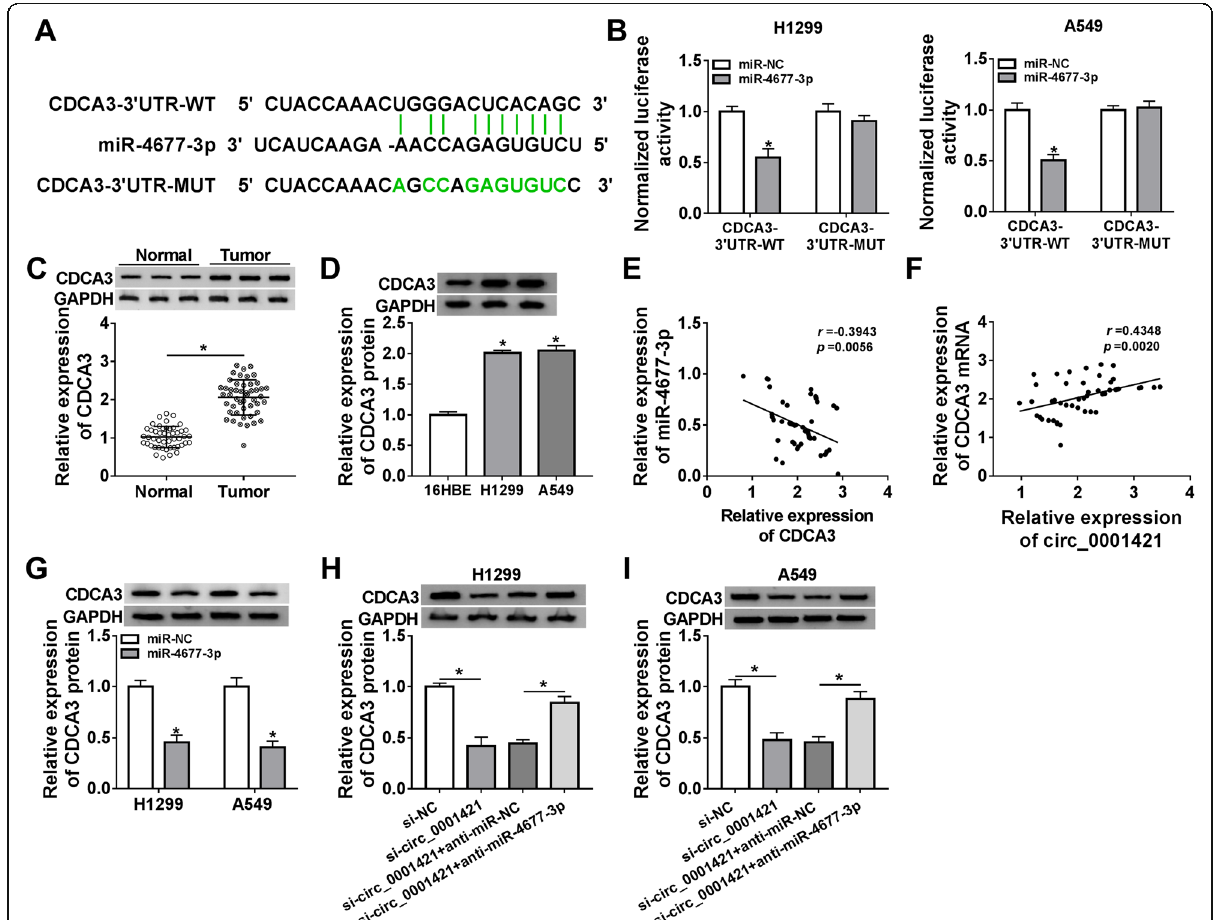
Fig. 5 CDCA3 was a target gene of miR-4677-3p in LC. a The predicted binding sites between miR-4677-3p and CDCA3 were shown. b The relationship between miR-4677-3p and CDCA3 in H1299 and A549 cells was analyzed by dual-luciferase reporter assay. c-d The protein of CDCA3 in LC tissues and cells versus that in normal tissues and cells was examined by western blot. e The correlation between miR-4677-3p and CDCA3 expression was appraised in LC tissues through Pearson coefficient analysis. f The correlation between miR-4677-3p and circ_0001421 level was appraised in LC tissues through Pearson coefficient analysis. g The protein of CDCA3 in H1299 and A549 cells transfected with miR-4677-3p or miR-NC was measured by western blot. h-i The protein of CDCA3 in H1299 and A549 cells transfected with si-NC, si-circ_0001421, si- circ_0001421 + anti-miR-NC or si-circ_0001421 + anti-miR-4677-3p was determined by western blot. * P <